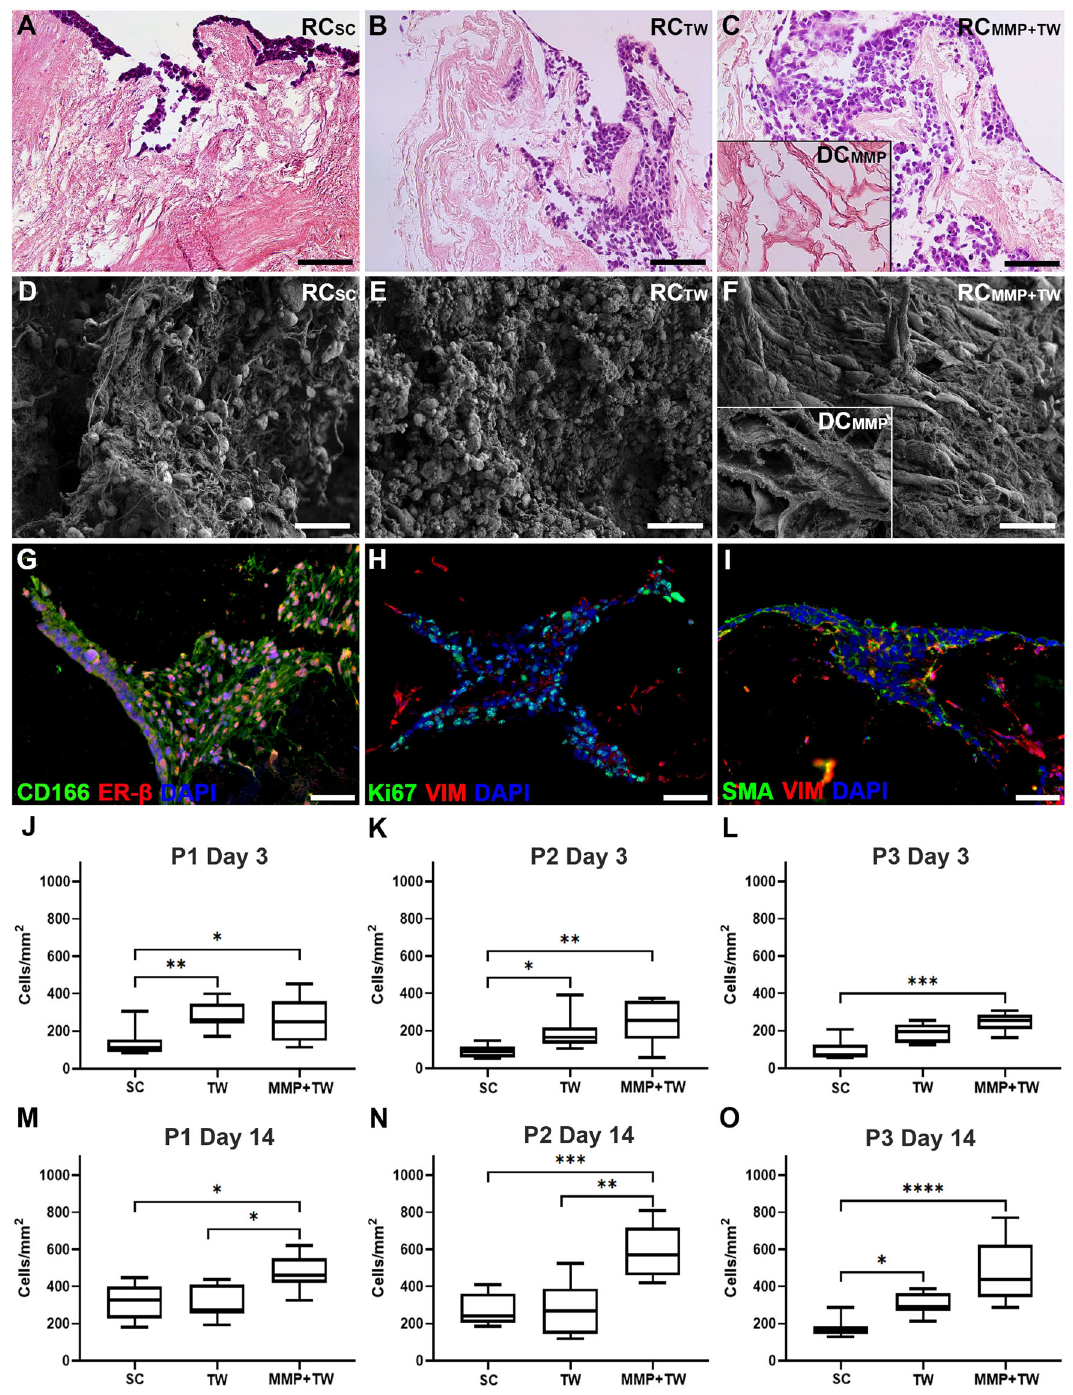
Fig. 6 Scaffold preconditioning and transwells signi fi cantly improved the recellularization ef fi ecinecy. Representative hematoxylin and eosin-stained sections of recellularized constructs from each culturing condition after 14 days in vitro ( A – C ; scale bar = 100 μ m). Cells were mainly located around the injection site when standard culturing conditions (RC SC ) were used and there was limited migration ( A ). However, the different recellularization strategies (transwells, RC TW ) and matrix metalloproteinase enzyme preconditioning in combination with TW (RC MMP + TW ) clearly improved the cell density and the cellular distribution throughout the scaffolding structure ( B , C ). Surface cell density was visualized by scanning electron microscope and showed a dense coverage, independent of strategy used ( D – F ; inserts in C and F show the scaffold preconditioned with MMPs without cells; DC MMP ; scale bar = 20 μ m). Sheep fetal stem cells kept their pluripotency during recellularization independent of scaffold type, evident by the continuation of CD166, estrogen receptor- β (ER- β ), vimentin (VIM), α -smooth muscle actin (SMA), and Ki67 (proliferation) expression ( G – I ; scale bars = 100 μ m). When the recellularization ef fi ciency was quanti fi ed and compared between groups and recellularization strategy, it became obvious that preconditioning with MMPs and using transwells were advantageous already after 3 days in vitro ( J – L ), but a substantial improvement was seen after 14 days ( M – O ) in protocol 1 (P1), protocol 2 (P2), and protocols 3 (P3), respectively. Graphs show box plot with each sample value, median ± IQR, and range. Signi fi cant levels; * p < 0.05; ** p < 0.01; *** p < 0.001, and **** p <